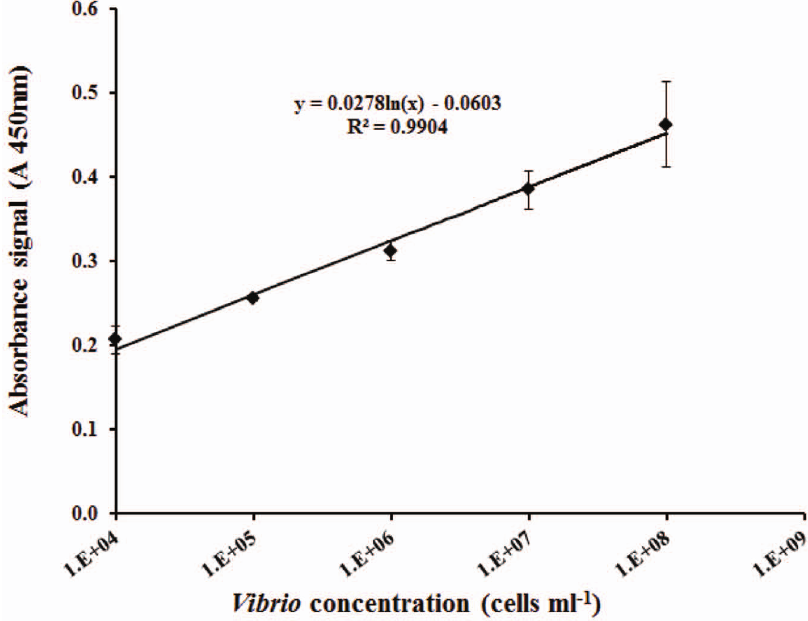
Figure 5. Linear part of the ELISA standard curve. Absorbance values obtained for increasing V. parahaemolyticus cell concentrations ranging from 1 6 10 4 to 1 6 10 8 cells ml 2 1 .